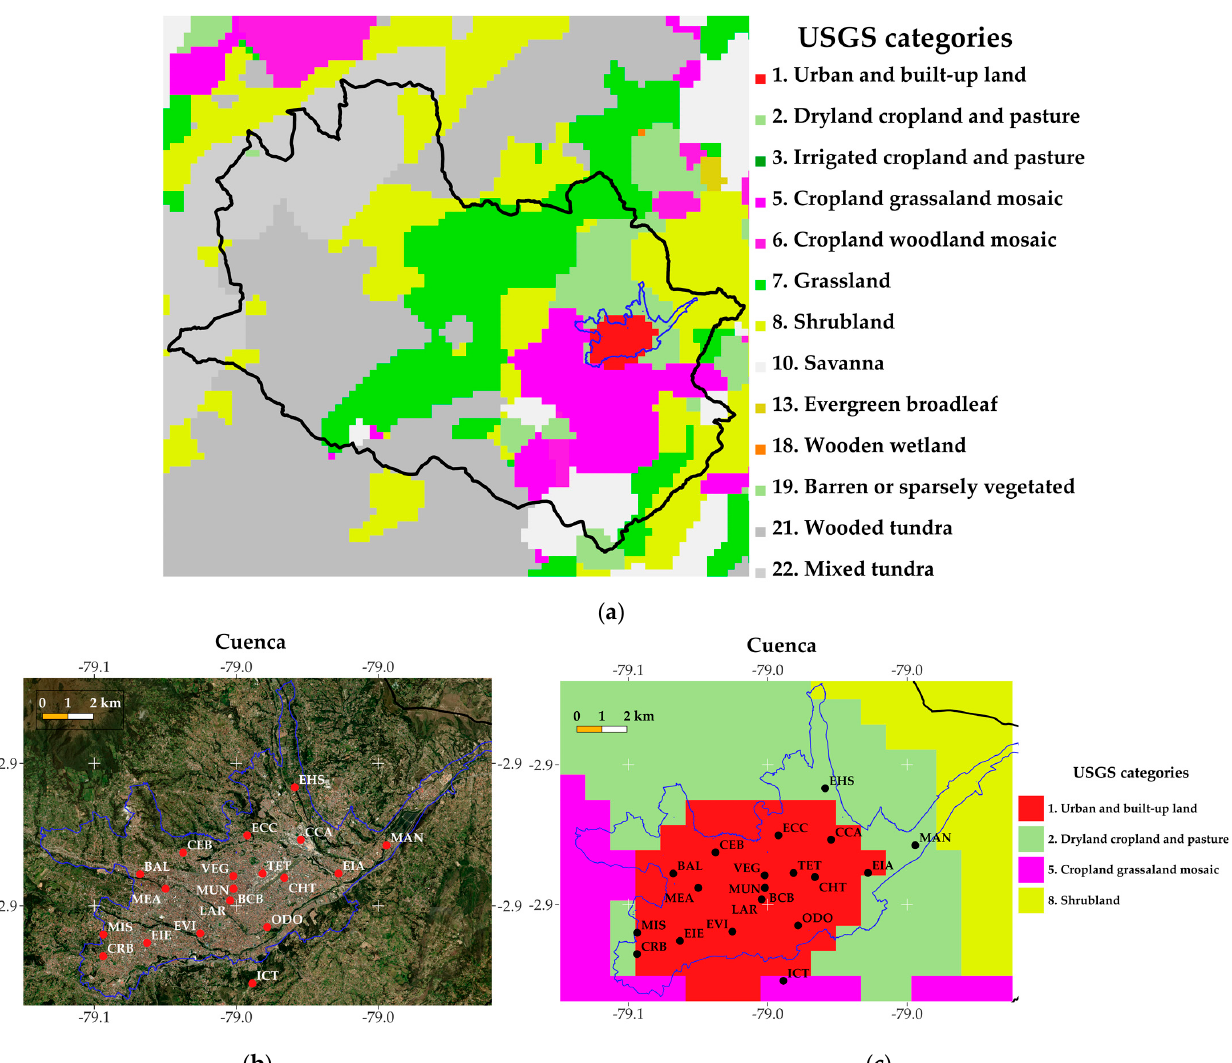
Figure 2. ( a ) Land use coverage (1 km of resolution) for the inner domain. Based on the US Geological Survey land use categories. ( b ) Zoom of the urban area. ( c ) Zoom of the urban area and the land use coverage for